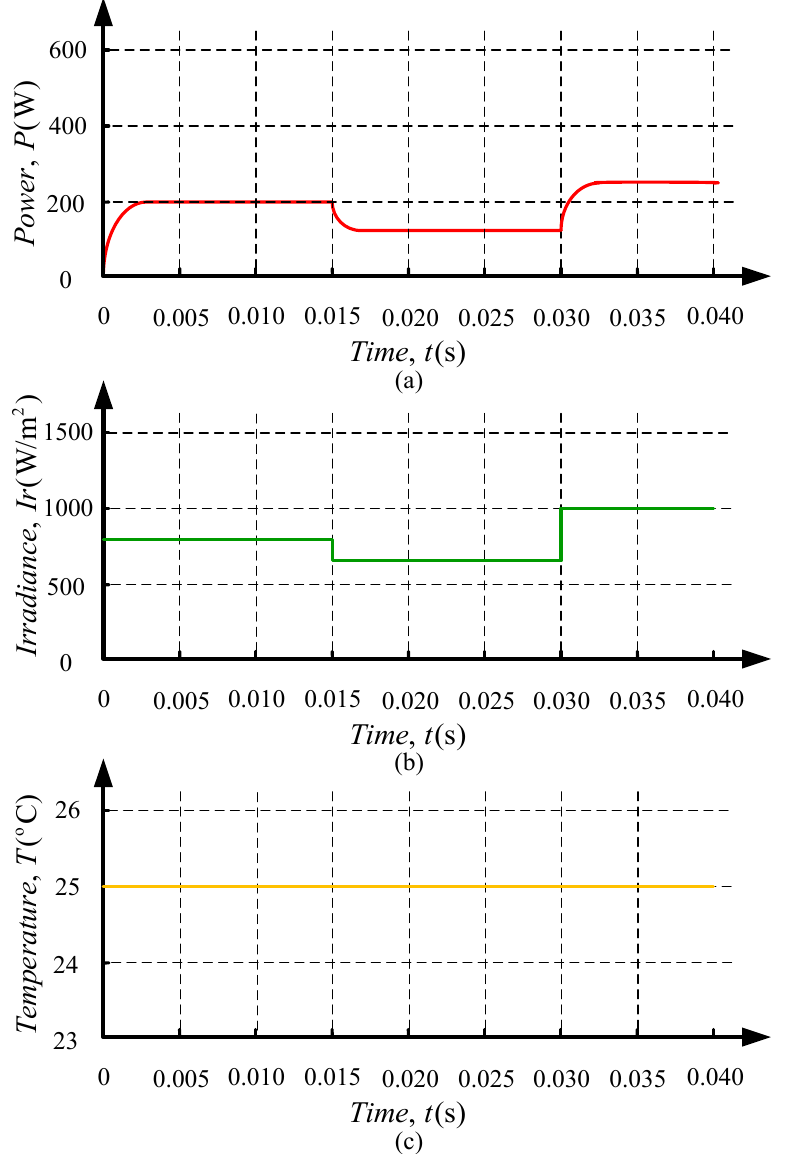
Figure 12. Output: ( a ) Power verses time at; ( b ) different irradiance and; ( c ) constant temperature. On the basis of the designed fuzzy rules, the fuzzy logic controllers generate the fuzzy logic PWM and decide what would be the duty ratio of the push pull boost converter switches shown in Figure 13a. The push pull boost converter operates in four states. In state 1, when the switch Q 1 is on, then the inductor would discharge, and output voltage would be positive. In state 2, switches Q 1 and Q 2 are ON simultaneously. During state 2, the inductor is charged, as shown in Figure 13c, that is, 4.3 A current flows, and the output voltage would be zero because the flux generated in both windings cancels each other out. In this state, the output capacitor provides the voltage to the load, which means that the capacitor would be discharged. In state 3, when the switch Q 2 is ON, then the voltage would be negative. Similarly, in state 4, both switches are ON simultaneously for zero output voltages, as shown in Figure 13b, that is, modified sine wave voltages, which are converted into 340 V DC through the rectifier diodes D 1 and D 2 , as shown in Figure 13d.